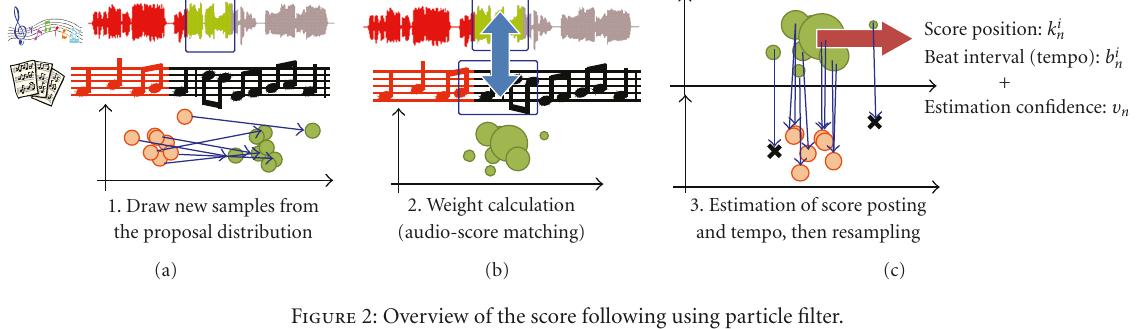
Figure 2: Overview of the score following using particle filter.